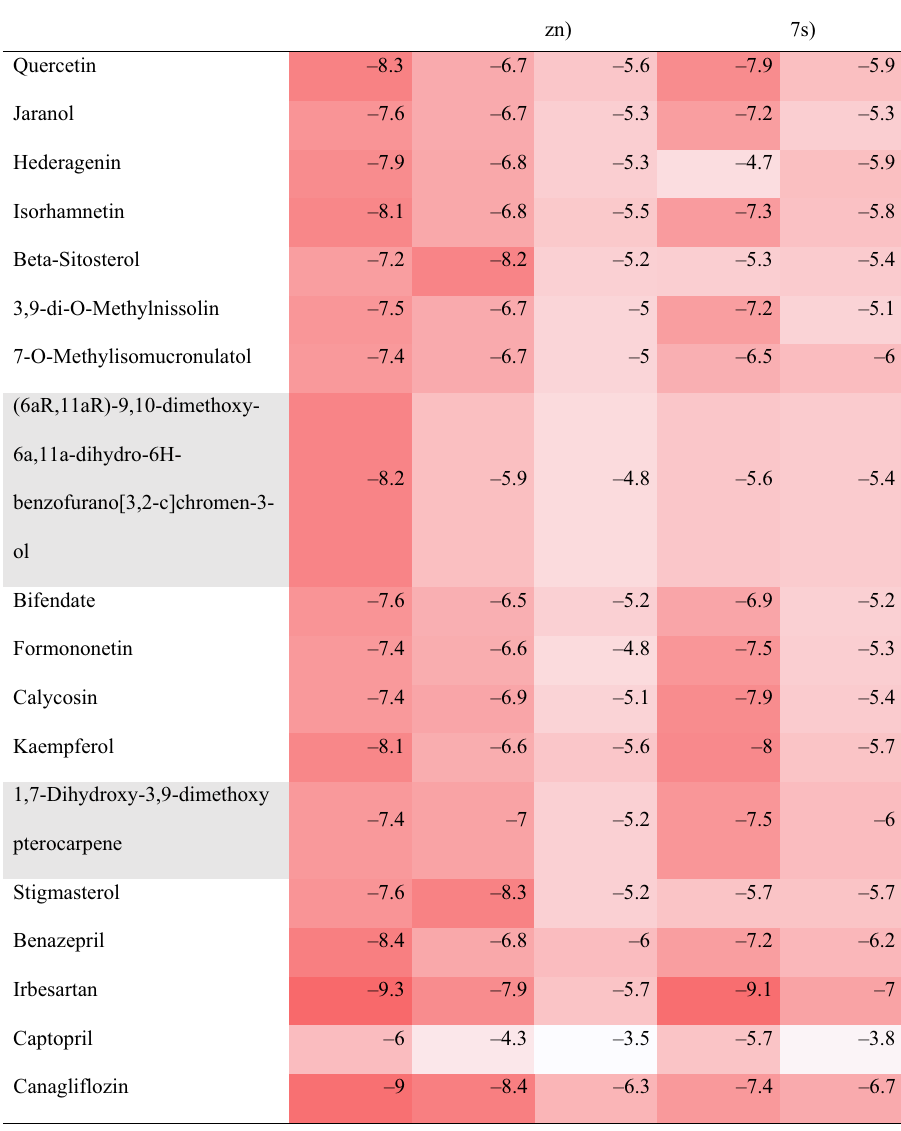
Table 3. Docking results of core target proteins and core active